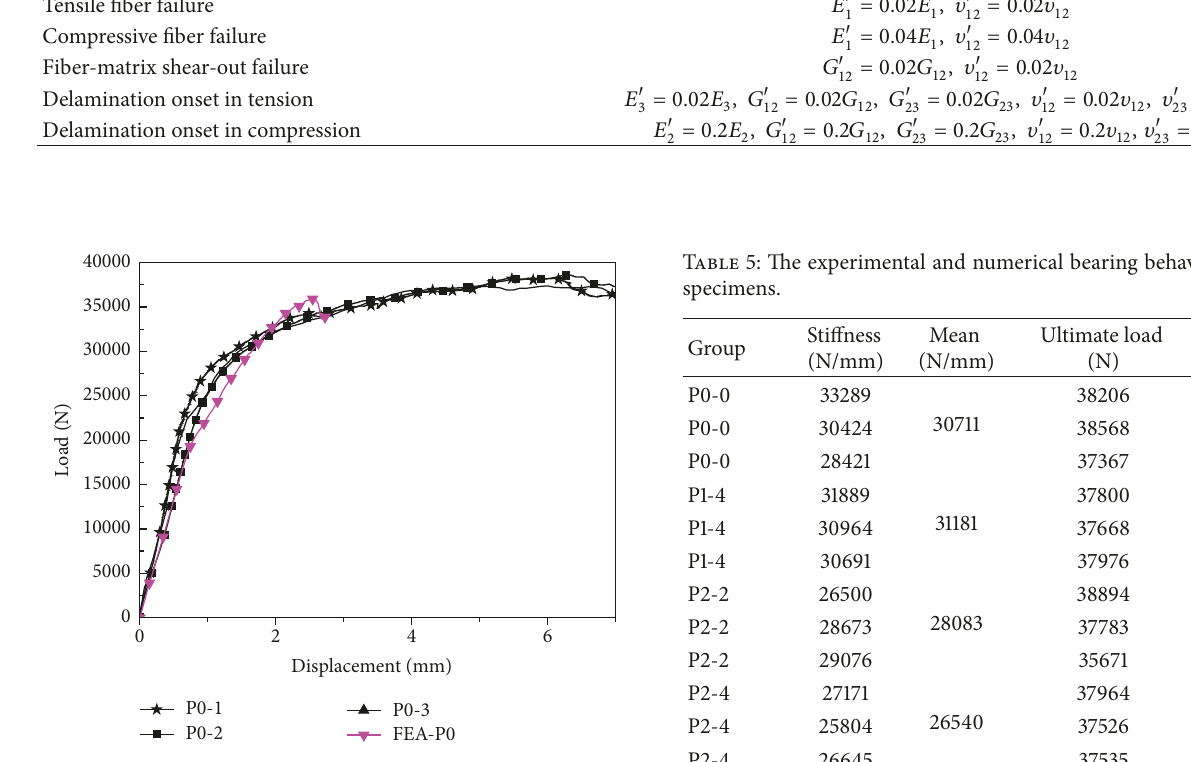
Figure 6: Comparison of numerical and experimental load–dis- placement curves.